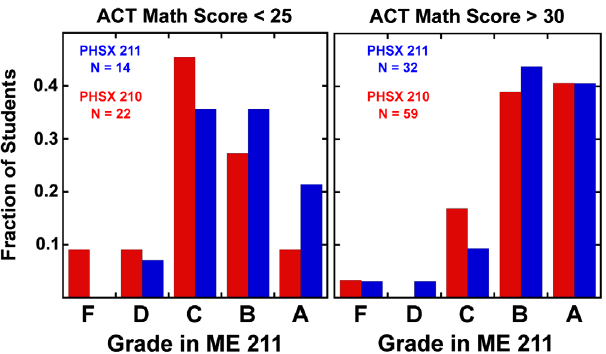
FIG. 6. The distribution of grades earned in ME 211 from the fall semester of 2015 through the spring semester of 2018 for students who completed PHSX 210 (red) or PHSX 211 (blue). Students with higher ( > 30 ) ACT math scores within each cohort were equally likely to earn higher grades. In contrast, students with lower ( < 25 ) ACT math scores were more likely to earn higher grades if they had been enrolled in PHSX